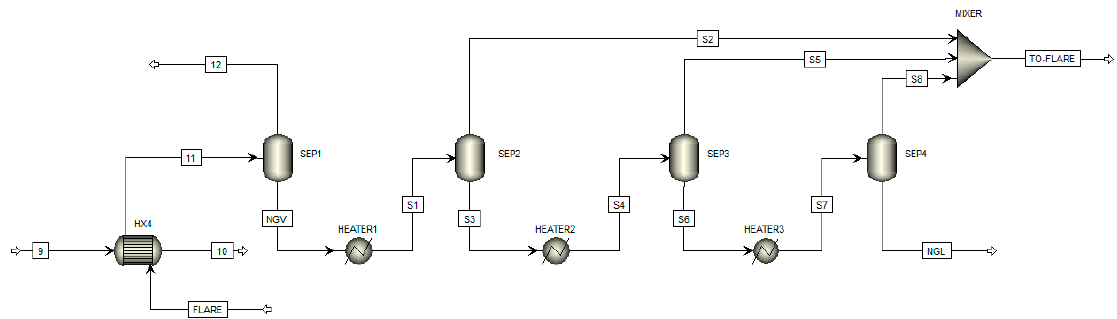
Figure 5. Process of separating H 2 S and natural gas liquid (NGL) from the remaining flare gas.